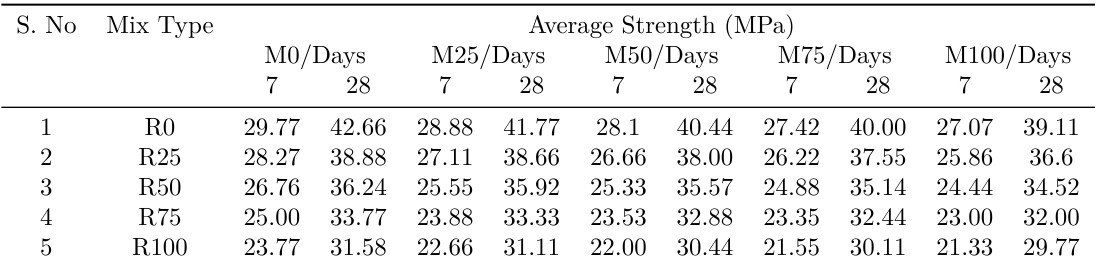
Table 2. Estimated compressive strength of various concrete